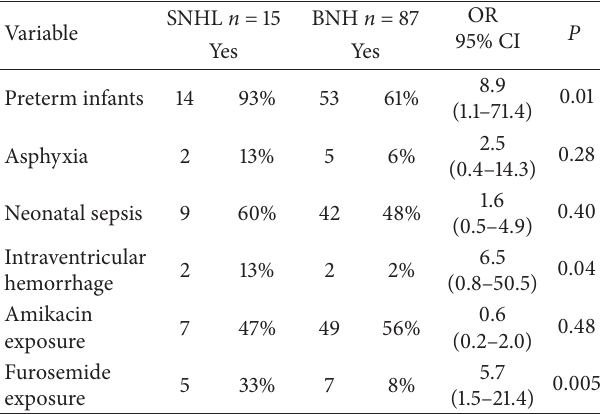
Table 3: Odds ratio calculations for risk-factors in children with SNHL and BNH with exchange